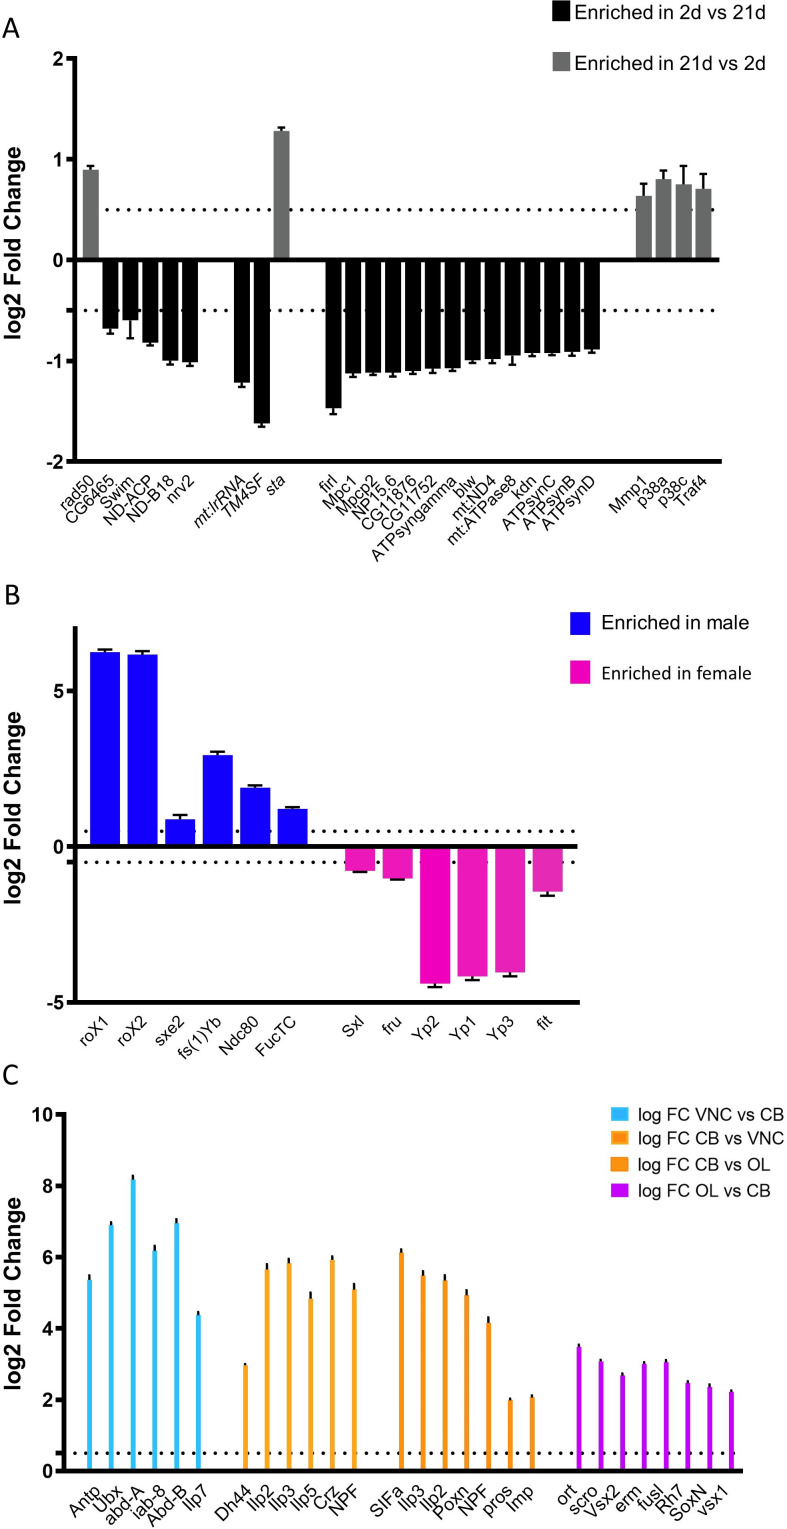
Validation of RNAseq data Validation of our RNA sequencing dataset was performed by comparing our dataset to other published datasets.Aggregated data based on (A) age (2d vs 21d, n = 6 replicates), sex (B, n = 9 replicates) or brain region (C n = 9 replicates) was compared to previously published datasets. Bar graphs show Mean log two fold change +/- SEM of select genes. Further details on references used are provided as a table in Figure 5—figure supplement 2—source data 1.Figure 5—figure supplement 2—source data 1.The list of comparisons and references for validation of RNAseq dataset.